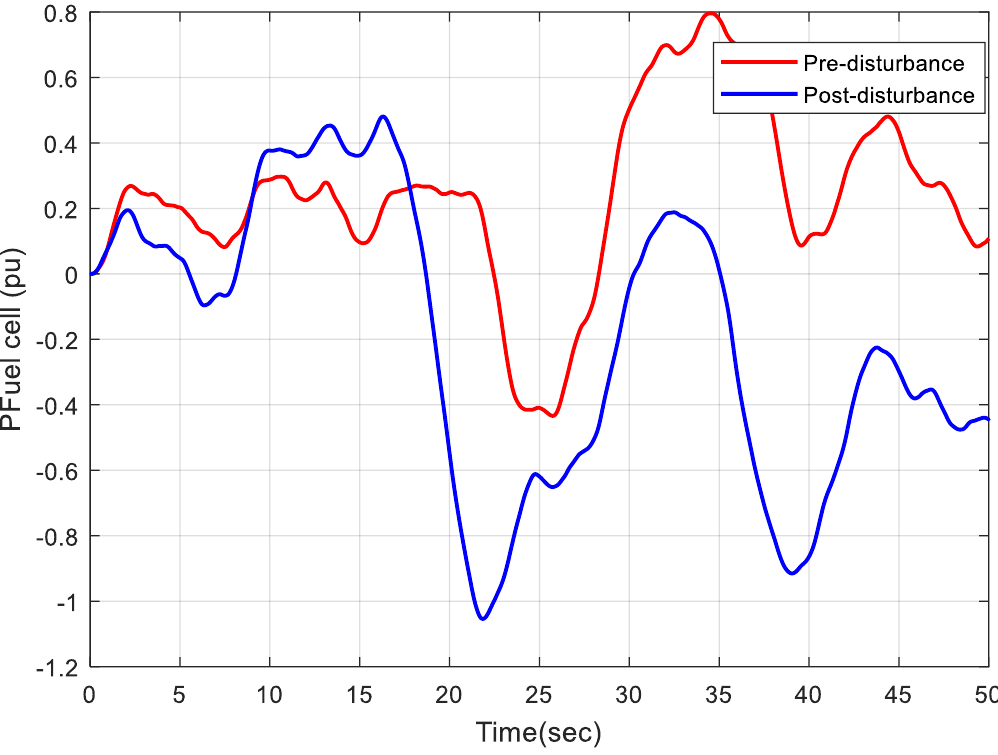
Figure 10. Fuel cell power (pre- and post-disturbance).